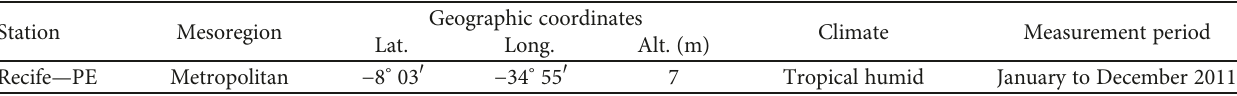
Table 1: Measurement station of the global and the erythemic solar radiation. Station